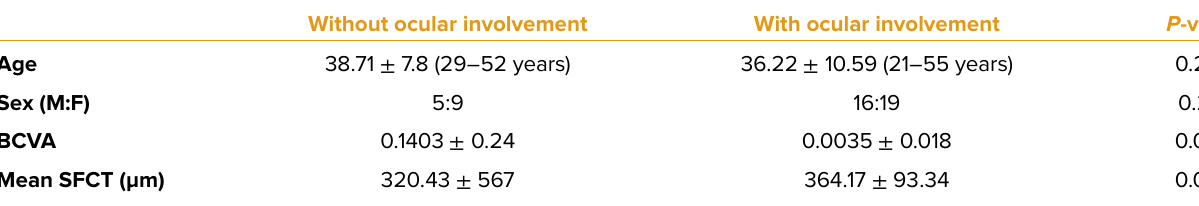
Table 1. Demographic and clinical finding of patients Without ocular involvement With ocular involvement P -value 38.71 ± 7.8 (29–52 years)